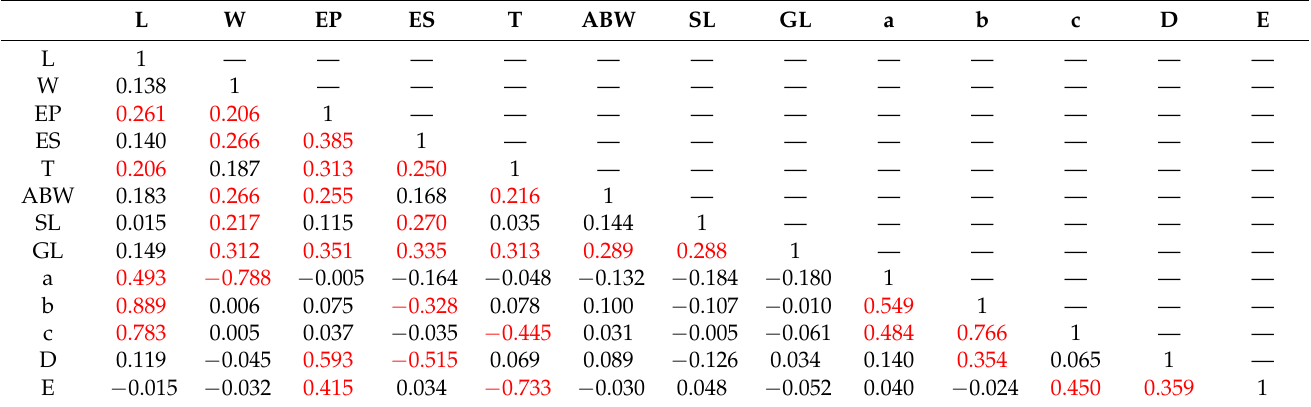
Table 7. Correlation coefficients among morphometric traits of first-stage male S. feltiae for all isolates. All coefficients that are statistically significant ( p < 0.05) are marked in red.